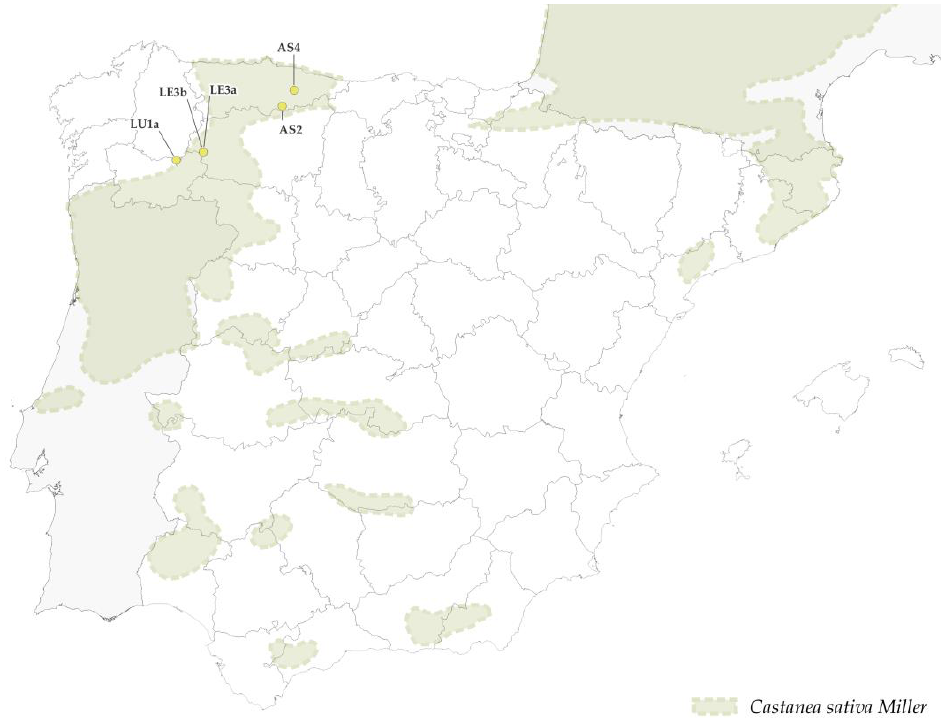
Figure 7. Distribution map of the species Castanea sativa Miller and locations of the case studies identified as belonging to this species. Map drawn up by the authors using information obtained from the database Chorological Data for the Main European Woody Species [42].